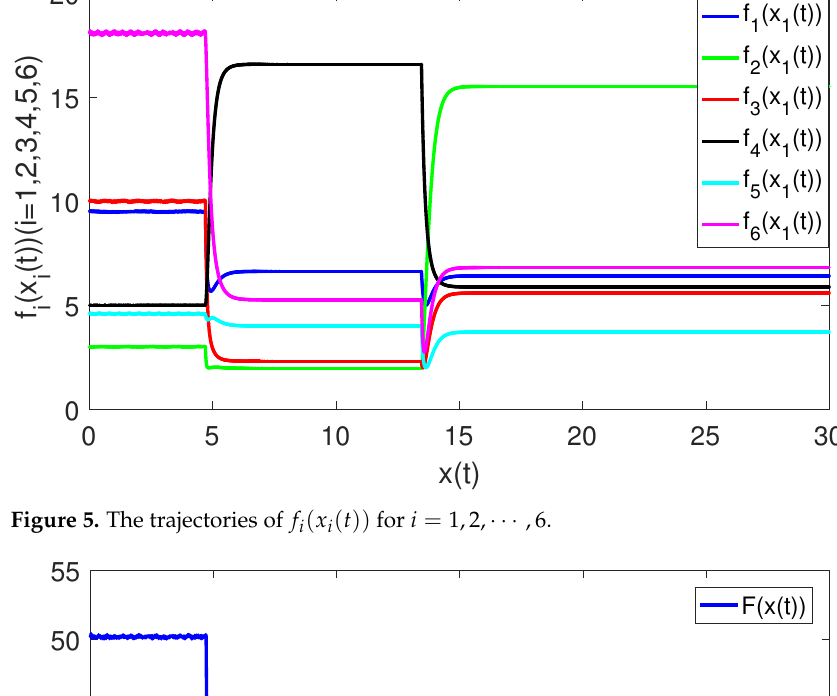
Figure 5. The trajectories of f i ( x i ( t )) for i = 1,2, · · · ,6.